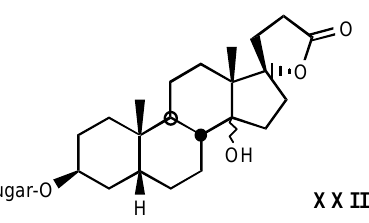
Figure 21. Structure of spirolactone ( XXII ).